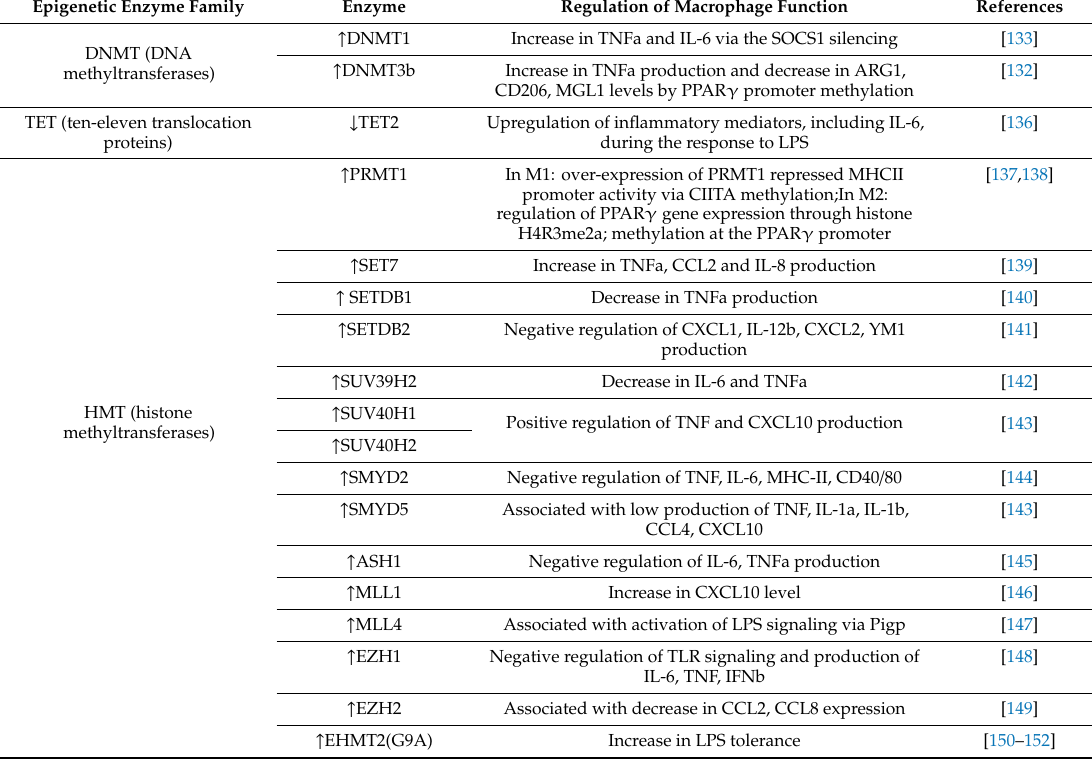
Table 2. Epigenetic e ff ectors involved in macrophage polarization to M1 or M2 direction. Epigenetic Enzyme